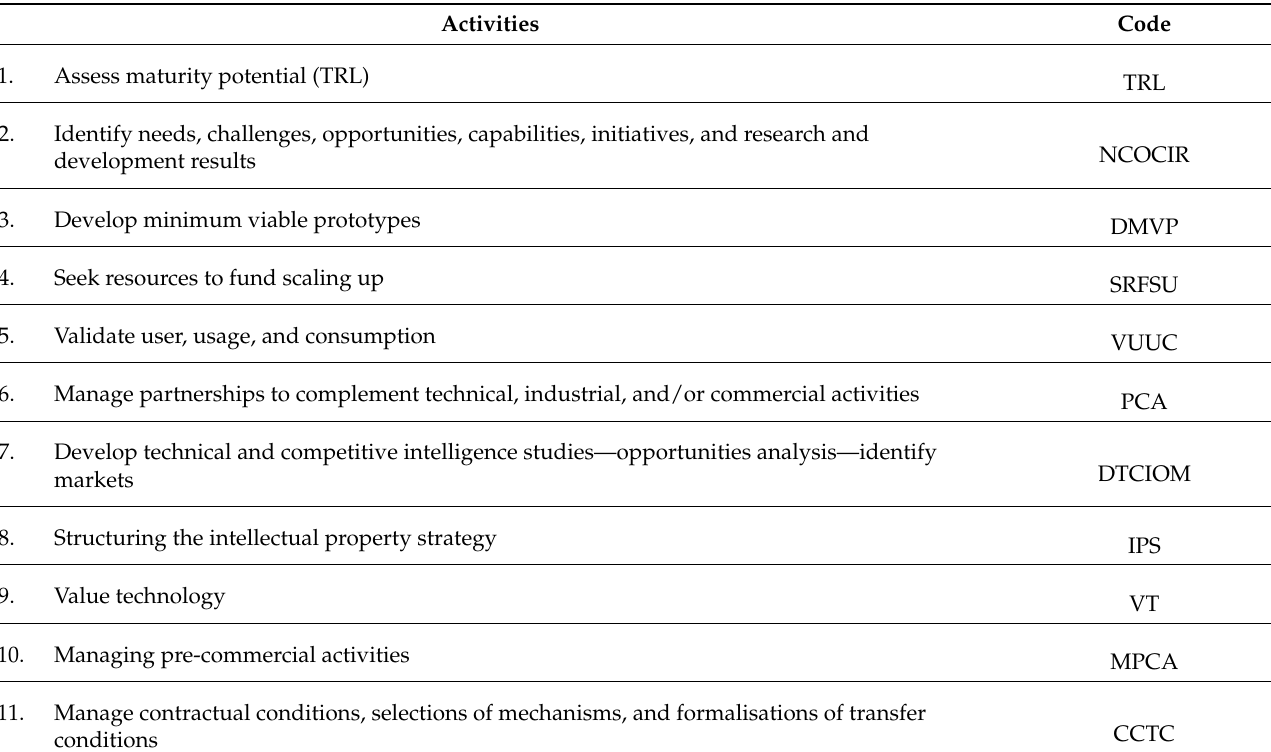
Table 1. Innovation